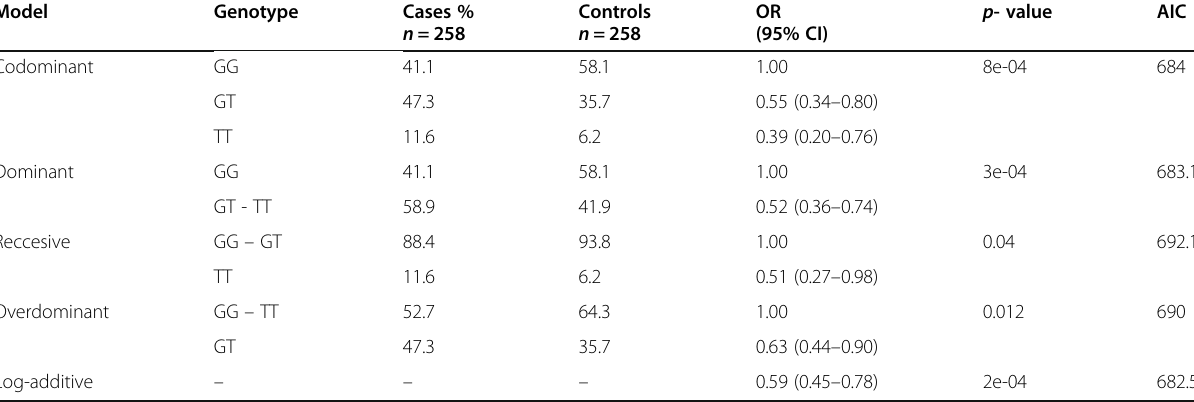
Table 4 ADIPOQ rs1501299 polymorphism using the multiple SNP inheritance models adjusted by age and BMI